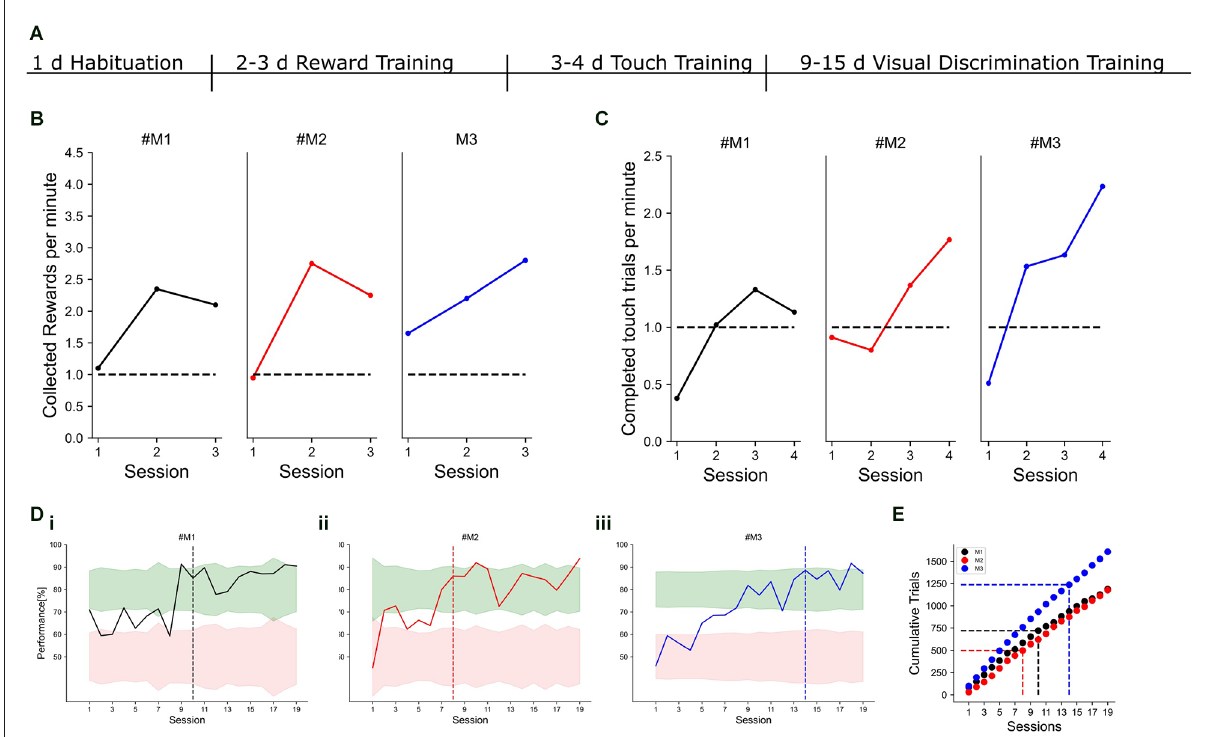
FIGURE4 Example learning curves. Individual mice are color-coded in black, red, and blue. (A) Timeline of training phases and their respective durations. (B) Performance measured in collected rewards per minute for three example mice. The criterion to reach the next training phase was set to one collected reward per minute. (C) Performance during touch training. Here, the screen had to be touched to receive a water reward. The criterion to reach the next training phase was set to one completed trial per minute. (Di–iii) Visual discrimination performance with a horizontal target and a vertical distractor for three different mice. The target criterion for expert task performance was set to 80% correct responses for two consecutive days. The session, in which the criterion was reached is indicated by the dashed line. Red and green shading show 95% confidence intervals for chance and expert performance, respectively. (E) Cumulative trials for the three example mice. The dashed vertical line indicates the session, in which the expert criterion was reached. The horizontal dashed line indicates the number of trials, which were needed to reach